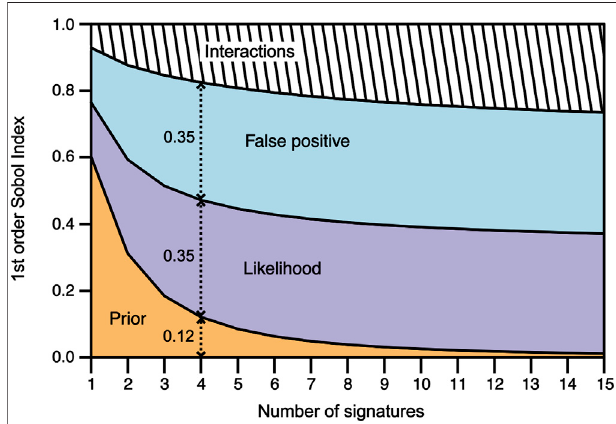
FIGURE 2 | Evolution of the fi rst order Sobol ’ indices along with the increasing number of signatures for the prior probability (orange area), the likelihood variable (purplearea), the false positive variable (bluearea),and their interactions (hatched area). The Sobol ’ index values of each variable are given by the vertical extent of the colored fi elds. For example, for n = 4, the prior probability has a fi rst Sobol ’ index value of 0.12, whereas the likelihood andfalsepositivevariableshave fi rstSobol ’ indexvaluesof0.35each.Inother words,whendetectingfourpotentialbiosignatures,theuncertaintyoftheprior is responsible for 12% the uncertainty of the biogenic assessment, whereas the uncertainty of the likelihood and false positive are distinctively responsible for 35% of the fi nal assessment ’ s uncertainty.